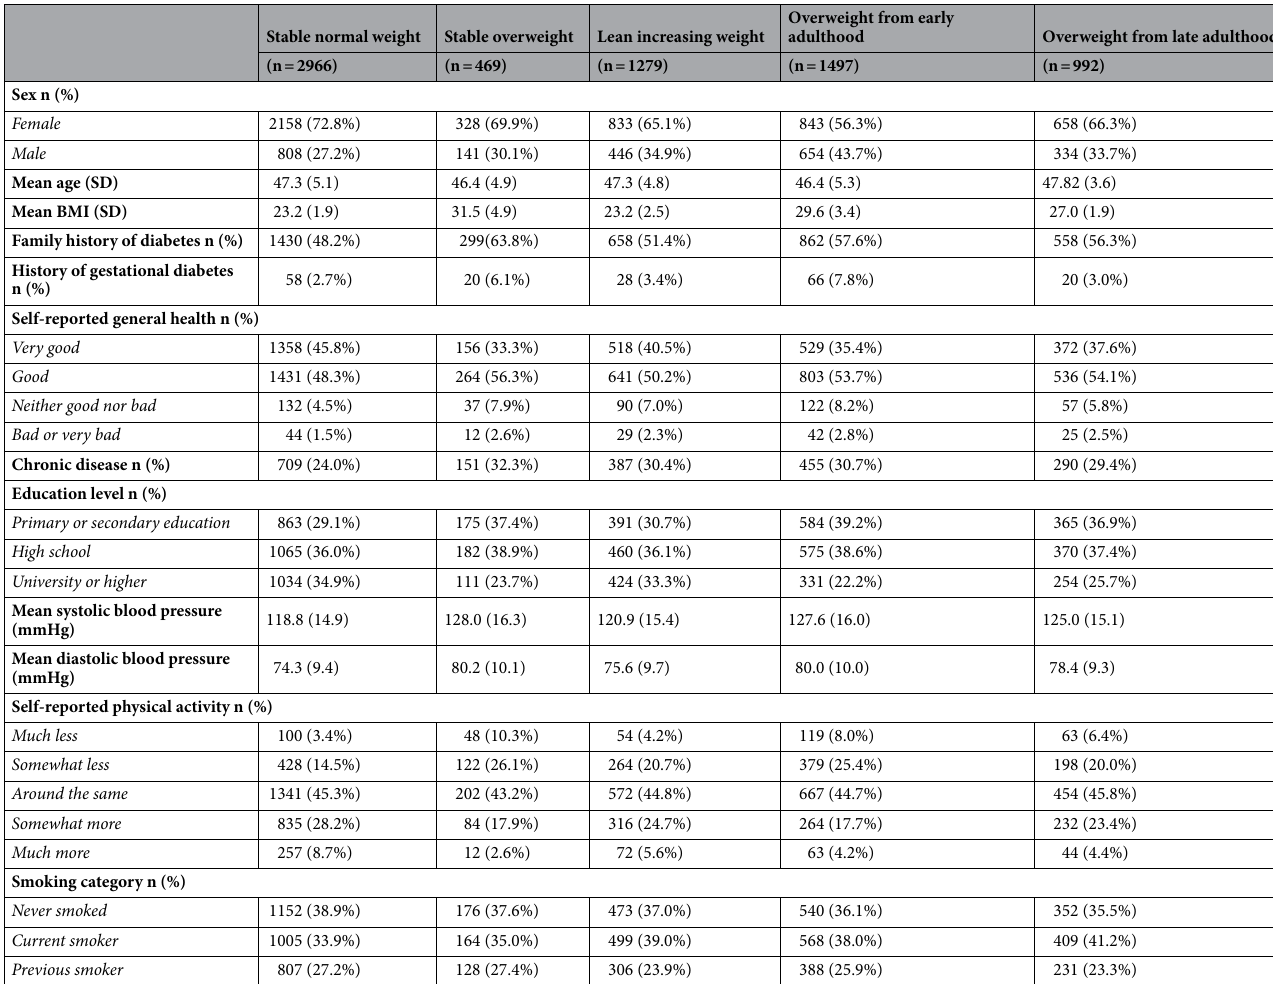
Table 1. Baseline characteristics of the study participants.